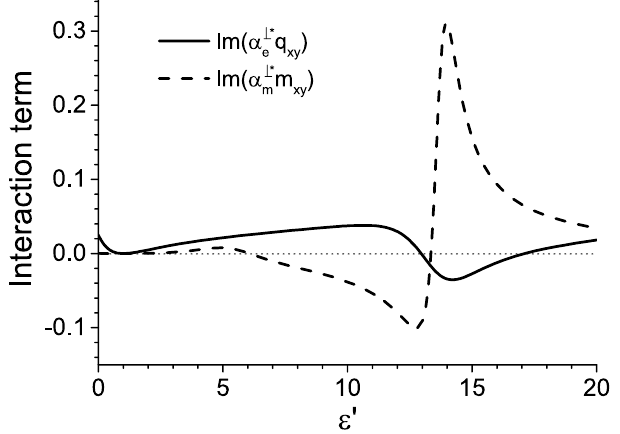
and α ⊥ ⁎ m Im( ) , as m xy e xy